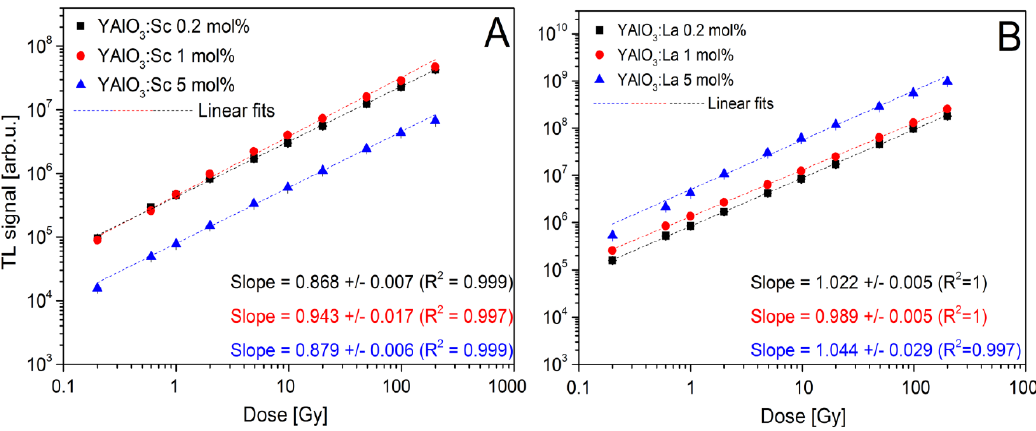
Figure 6. The dose–response characteristics for YAlO 3 :Sc ( A ) and YAlO 3 :La ( B ) crystals with di ff erent dopant concentrations. Each point was obtained by a glow-curve integration over the temperature range of 325–625 K. The standard deviation was at the level below